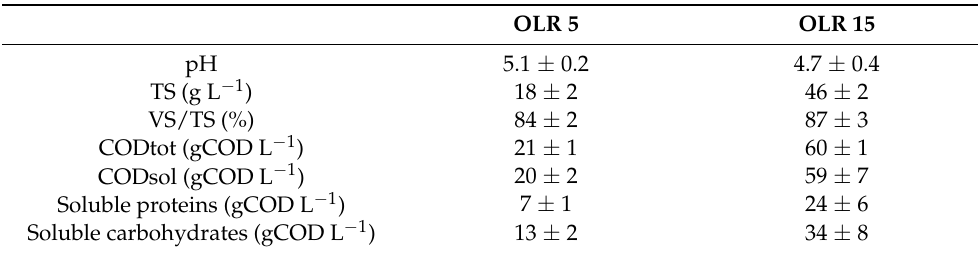
Table 1. Characterisation of the liquid extracts fed into fermenter operating at organic loading rate (OLR) 5 and OLR 15.